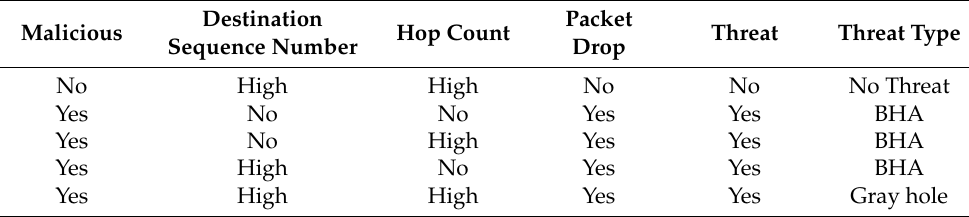
Table 1. Node (normal and malicious) behavior.